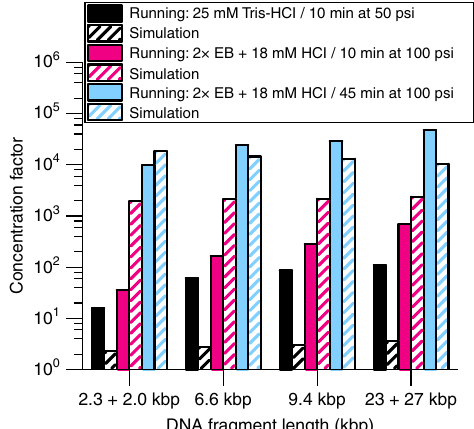
Fig. 8 Concentration factors increase with optimized buffer solutes and longer concentration times. Experimental (solid) and simulated (striped) results compare concentration factors with 25 mM Tris-HCl running buffer (black) with 100 mM EBH-18 running buffer at 10 min (pink) and 45 min (blue) at each buffer ’ s optimal fl ow rate. Simulated (striped) and experimental (solid) results show the same trend of increasing concentration factors with increased concentration time and mobility difference between the majority cation and anion in the running buffer. The 2× EB + 18 mM HCl running buffer has a greater mobility difference between the majority cation and anion and generates higher concentration factors than the 25 mM Tris-HCl running buffer over the same counter fl ow time. Further increase of the counter fl ow time allows more DNA to accumulate in the injection region for higher concentration factors. Concentration factors over 10,000-fold were achieved experimentally point-of-care sample handling, and biomolecular assays, both as a stand-alone technology and coupled to subsequent molecular analysis operations. The integration of MRT with SML-FSHS represents a truly electrode-free platform for highly sensitive and quantitative DNA separation and sizing.